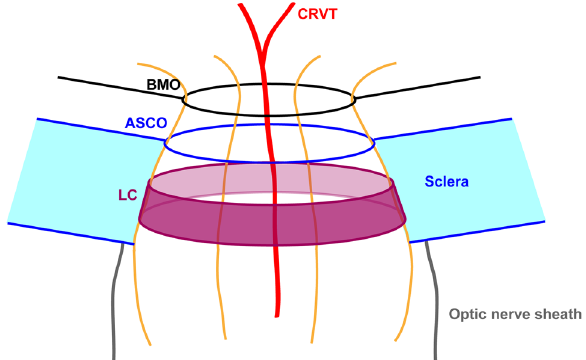
Figure 1. Schematic drawing of three openings in optic nerve head (ONH) canal. The black lines indicate the Bruch’s membrane (BM) with central opening (BMO). The blue lines indicate the sclera and its anterior opening, defined as the anterior scleral opening (ASCO; blue circle). The lamina cribrosa (LC; purple cylinder) is located at a lower level than the ASCO is. The axons passing through the ONH canal are drawn as yellow fibers. The central retinal vascular trunk (CRVT; red line) also passes through the ONH canal. The optic nerve sheath (gray line) is anchored to the posterior sclera near the ONH canal. The alignments among the BMO, ASCO, and LC are known to change during eyeball expansion. This study was designed to compare the ASCO and CRVT (a surrogate of LC position) offsets from the BMO.